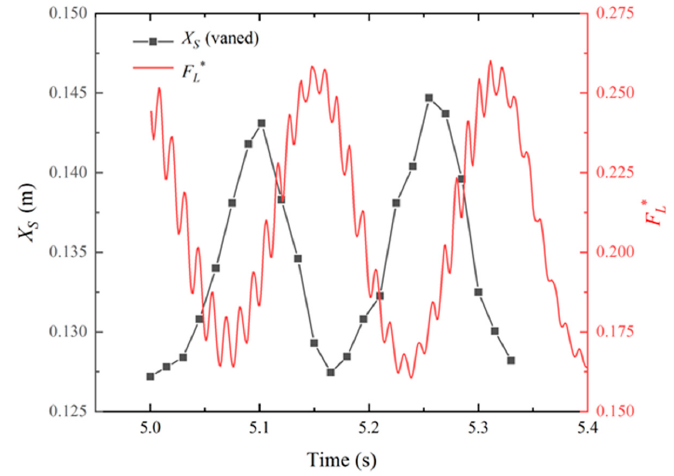
Figure 14. Lift force acting on a splitter vane.